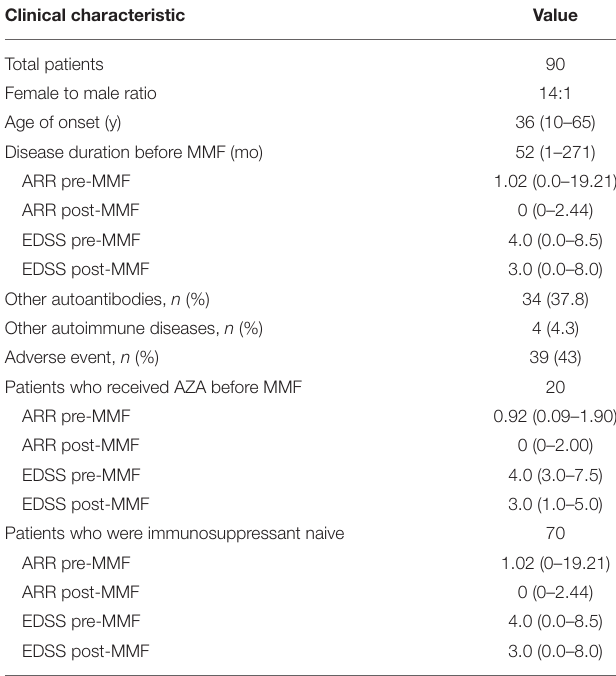
TABLE 1 | Clinical characteristics of the 90 NMOSD